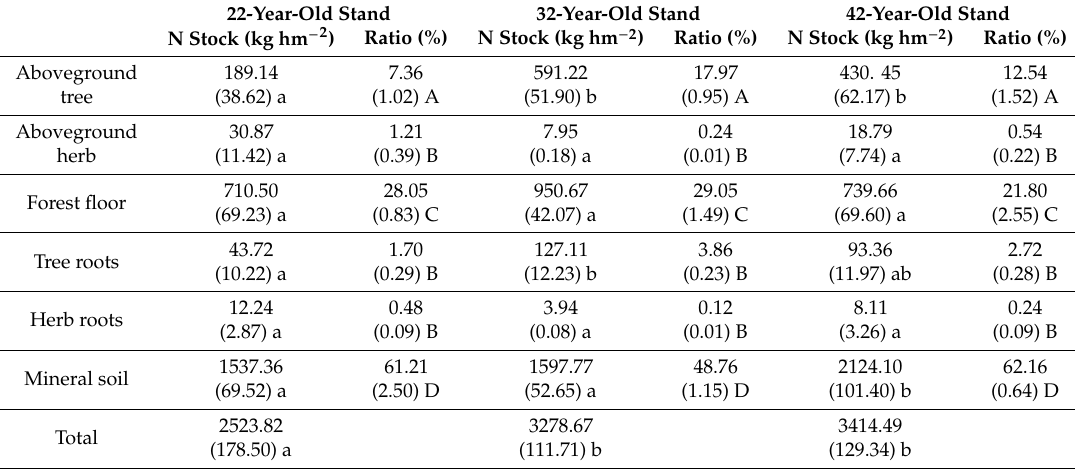
Table 6. The N Stocks of di ff erent components and their contributions to the total ecosystem N pool in three di ff erent aged